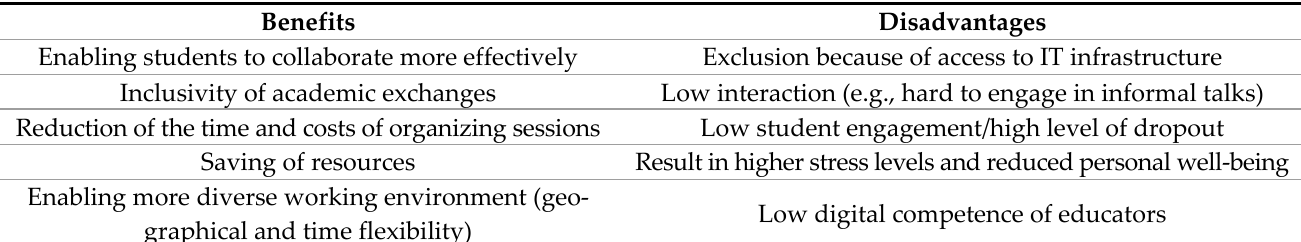
Table 2. Benefits and disadvantages of digital tools